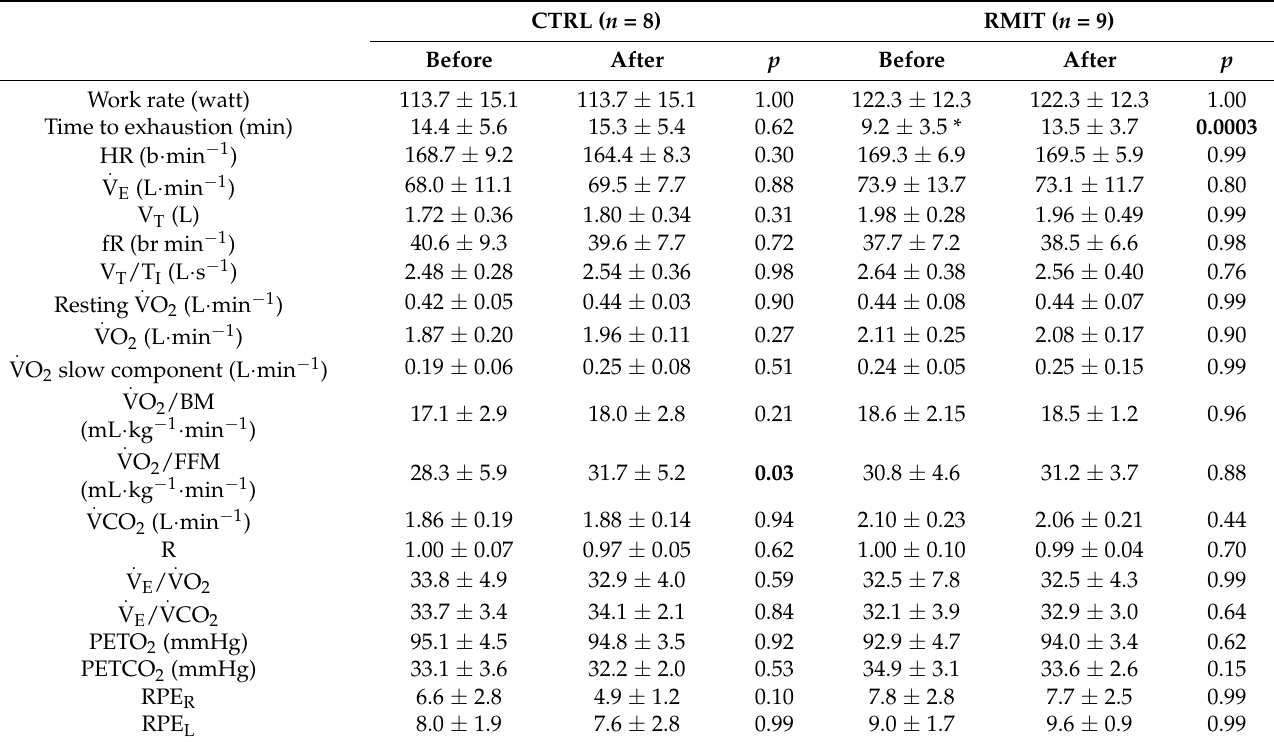
Table 4. End-exercise values of the main investigated variables determined during the last minute of the constant work rate exercise carried out at 130% of the work rate at GET, before and after the standard intervention of body mass reduction combined with a control training and with RMIT. CTRL ( n = 8) RMIT ( n = 9) Before After p Before After p